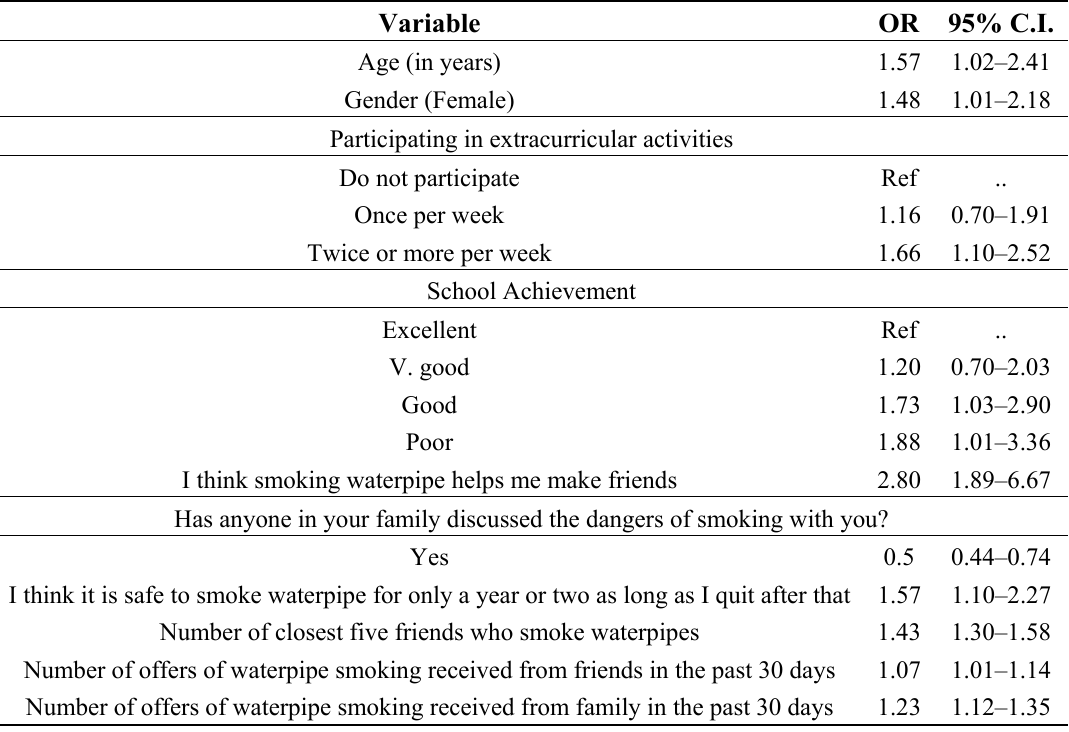
Table 5. Adjusted effect of predictors of waterpipe